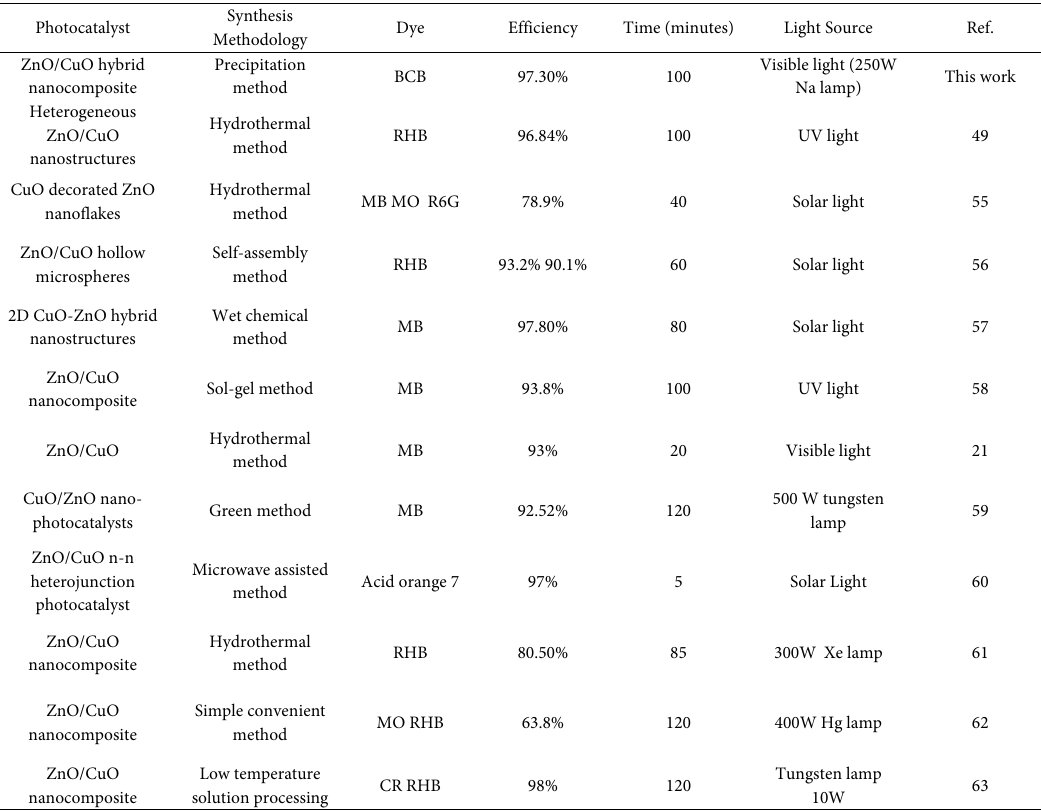
Table 4. Comparison of the photocatalysis results with recently reported studies